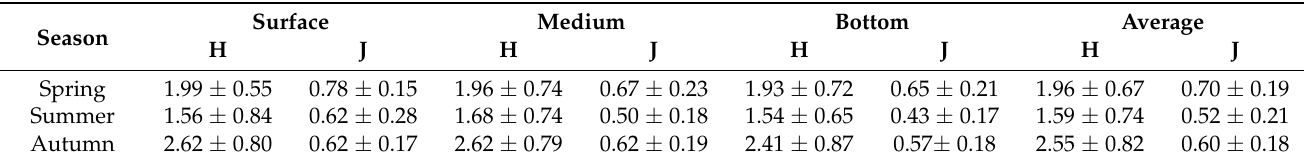
Table 4. The diversity index (H) and evenness index (J) of phytoplankton community in three seasons (spring, summer, and autumn) in the BS and NYS.